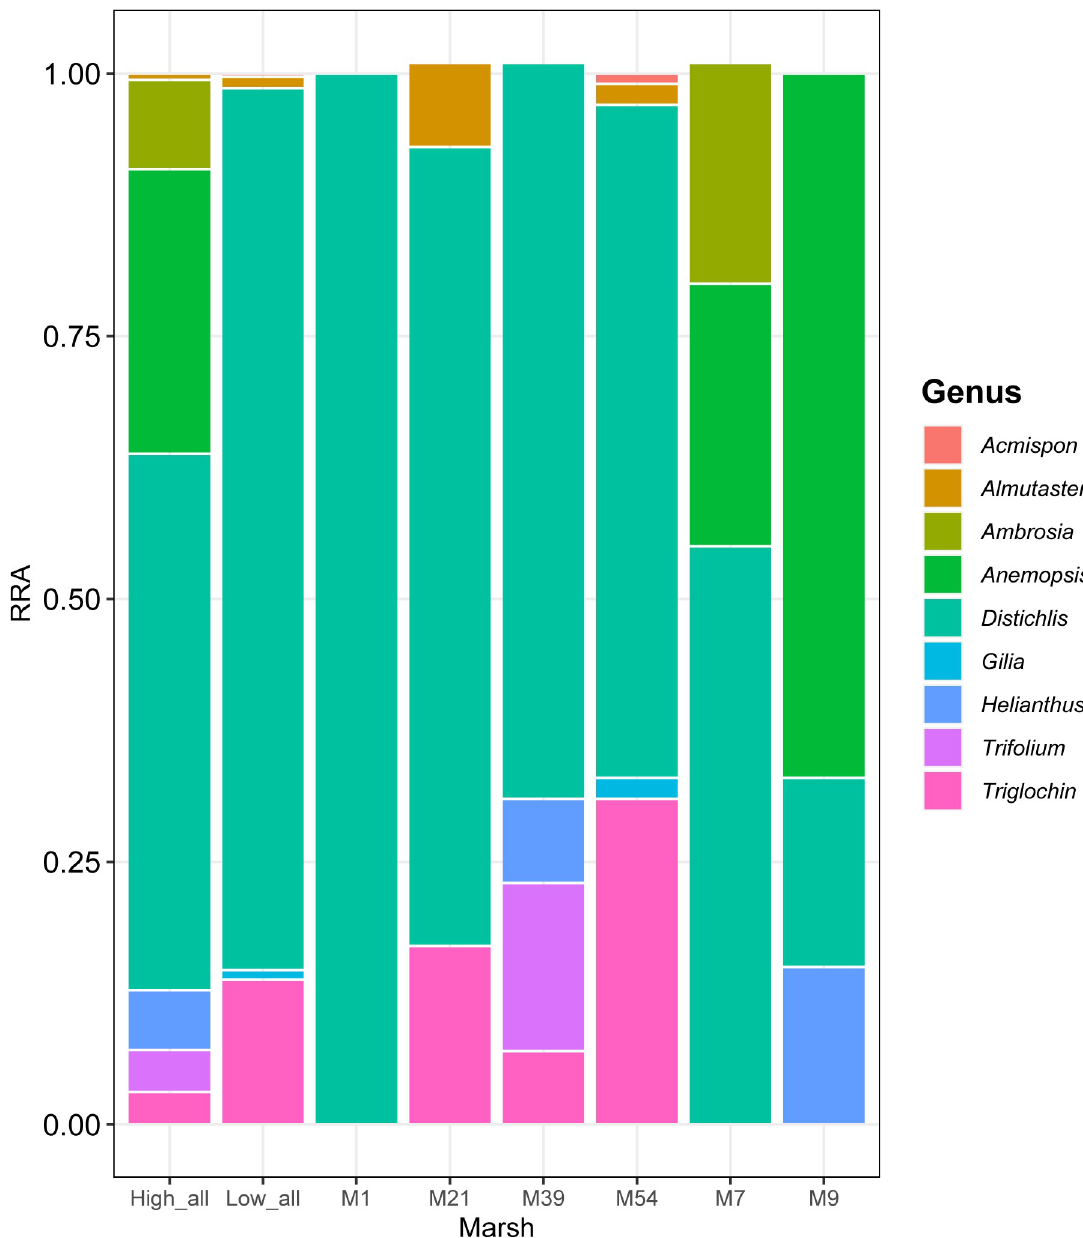
Fig 2. Relative read abundance (RRA, y-axis) of nine non- Schoenoplectus diet items detected by metabarcoding in feces of the Amargosa vole in six different marshes (listed on x-axis) near Tecopa, California, and when marshes were grouped as having high or low floral diversity (columns 1 and 2,